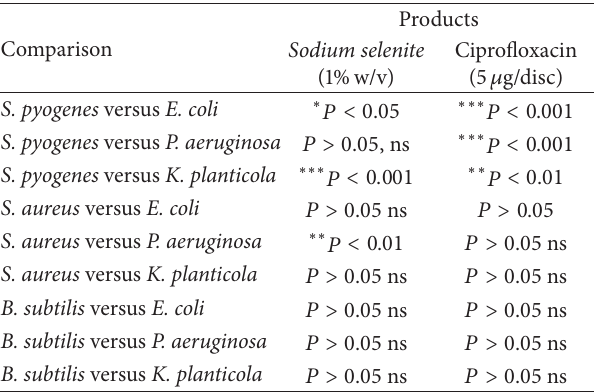
Table 3: Gram positive versus Gram negative comparative